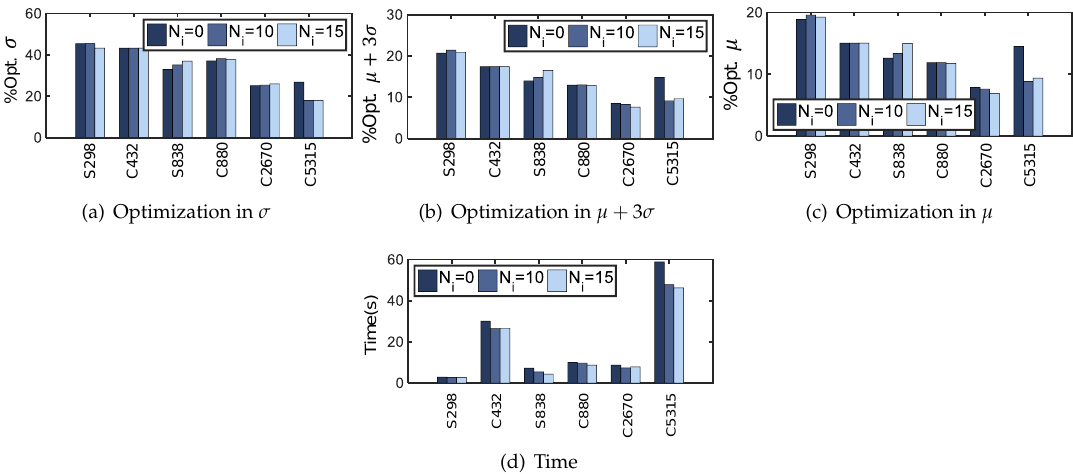
Figure 7. Benefit in computing time using the coarse selection criticality